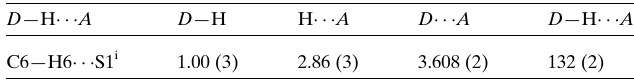
Table 1 Hydrogen-bond geometry (A˚ , (cid:3) ).